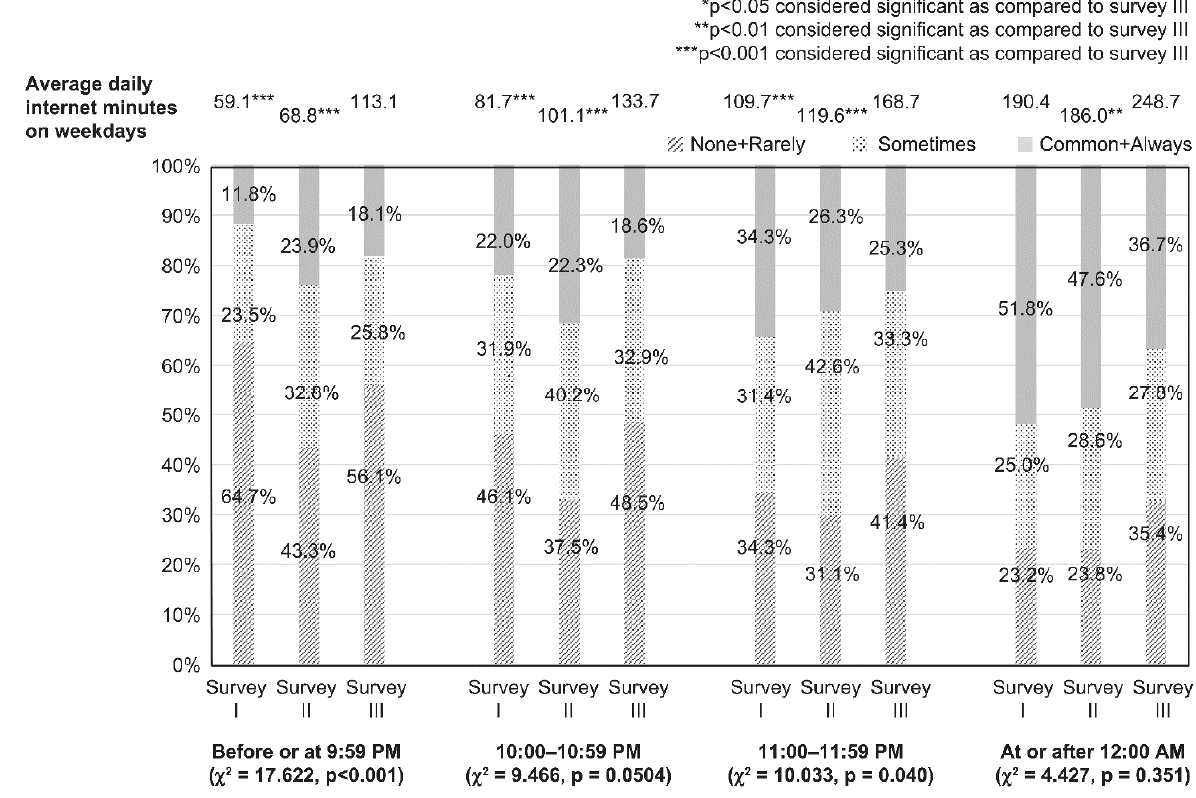
Figure 3. Comparison of sleepiness during classes according to bedtime on weekdays in each survey. For each bedtime on weekdays, the comparison of degree of sleepiness during classes between each survey was performed using χ 2 analysis. For each bedtime on weekdays, a comparison of internet use duration (in minutes) on weekdays among groups as per survey year was made using ANOVA. A post hoc analysis between the group from survey III and the groups from the other surveys (survey I and II) was performed using Dunnett’s test.